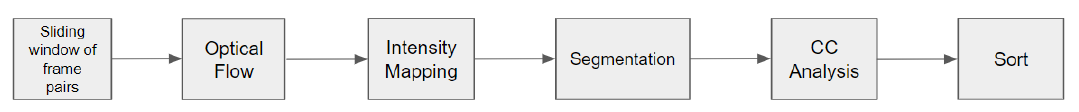
Figure 2. Proposed optical flow based target detection and tracking workflow. The workflow was implemented in Python.